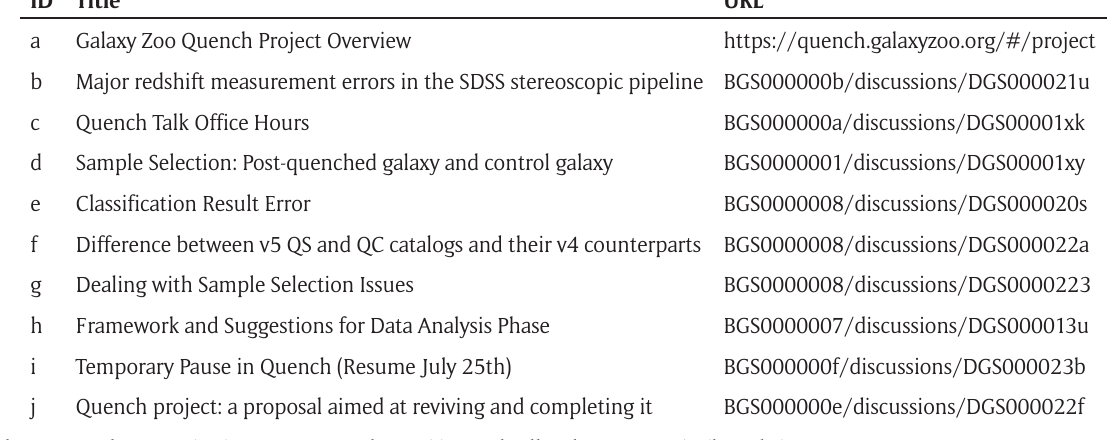
Table 1: Galaxy Zoo Quench talk posts referenced in the